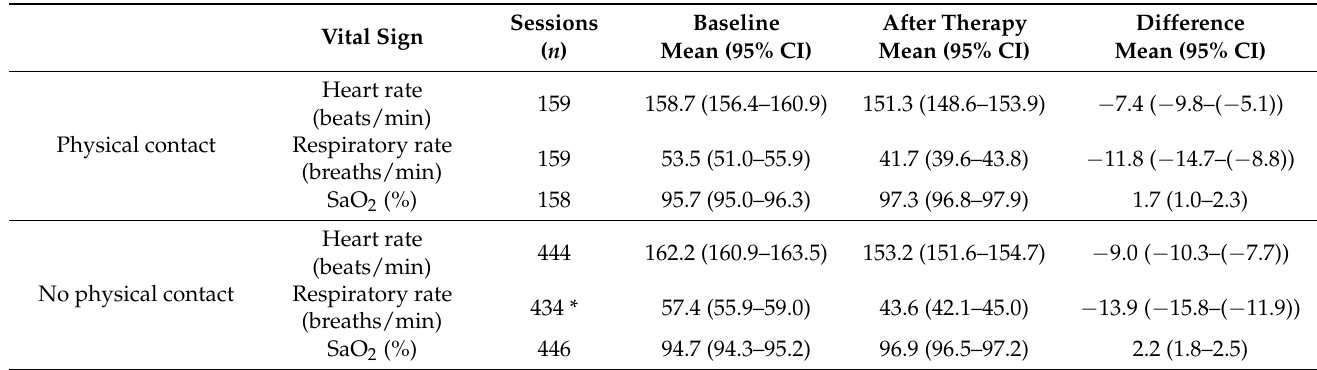
Table 2. Unadjusted heart rate, respiratory rate and oxygen saturation before and after music therapy sessions with and without physical contact to parents.